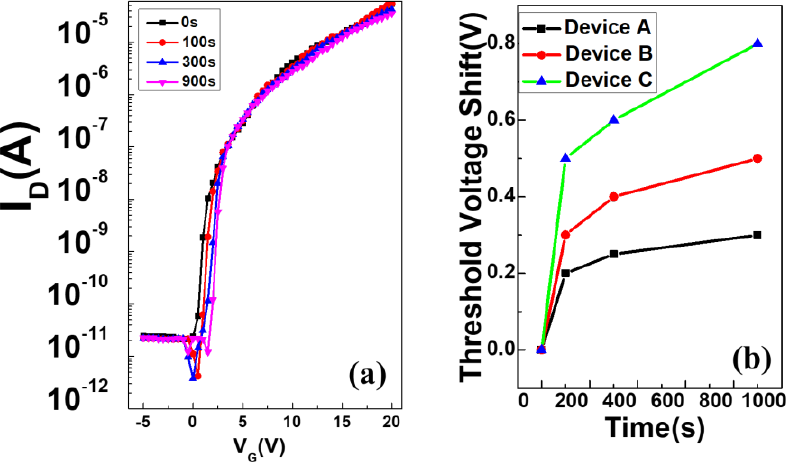
Figure 7. ( a ) The bias stability of device B; ( b ) the relation of V th shift and gate-bias stress time of device A, B, and C.